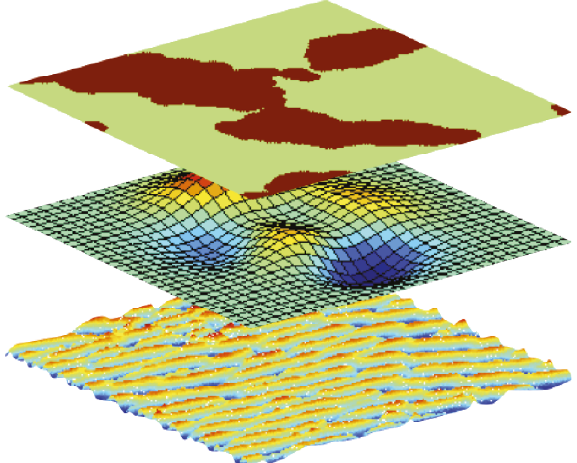
Figure 3: Decomposition of the 3D representation of the seafloor in 3 layers: partition between the di ff erent types of seabed, global elevation, roughness and texture.